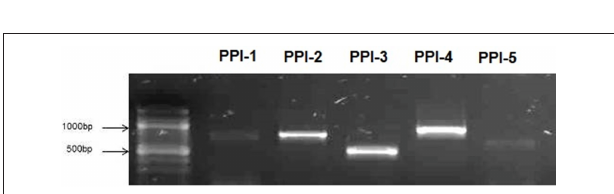
FIGURE 3 | PCR performed on colonies identified from the QDO/X/A (showing PPI) to identify inserts in prey pGADT7-rec clones). PCR performed on the five blue colonies (PPI-1, PPI-2, PPI-3, PPI-4, and PPI-5) identified from the QDO/X/A showed variation in the product length of inserts amplified from